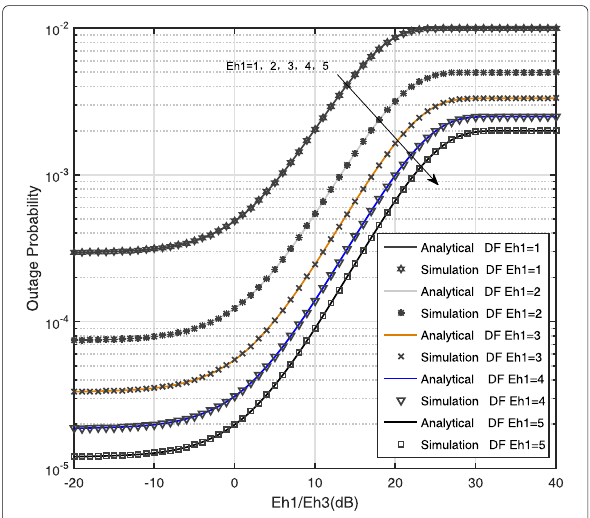
Fig. 8 Outage probability versus γ th for E h 2 = E h 3 with DF